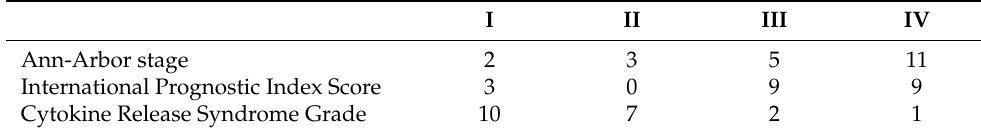
Table 1. Patient